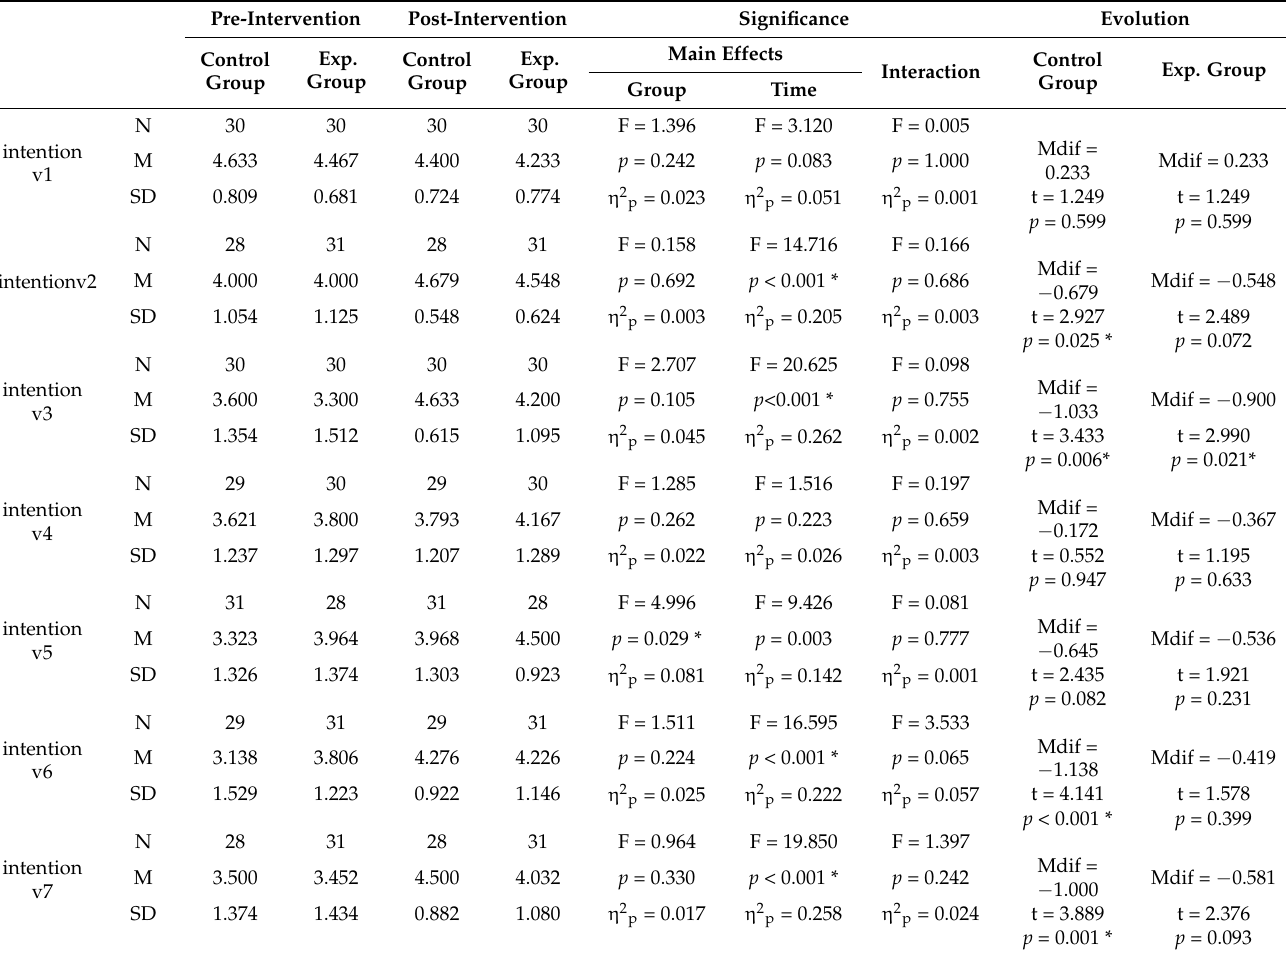
Control Exp. Group Interaction Group